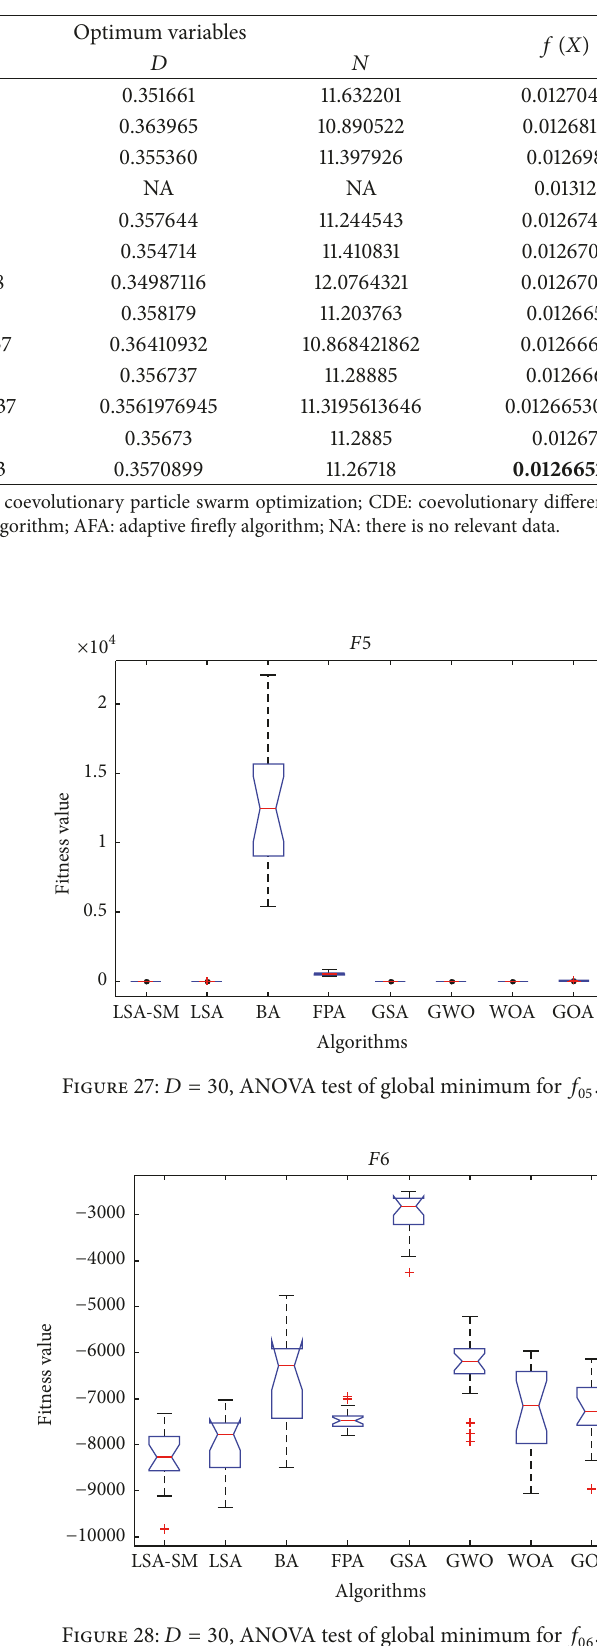
Table 8: Best results of the spring design example by different methods.